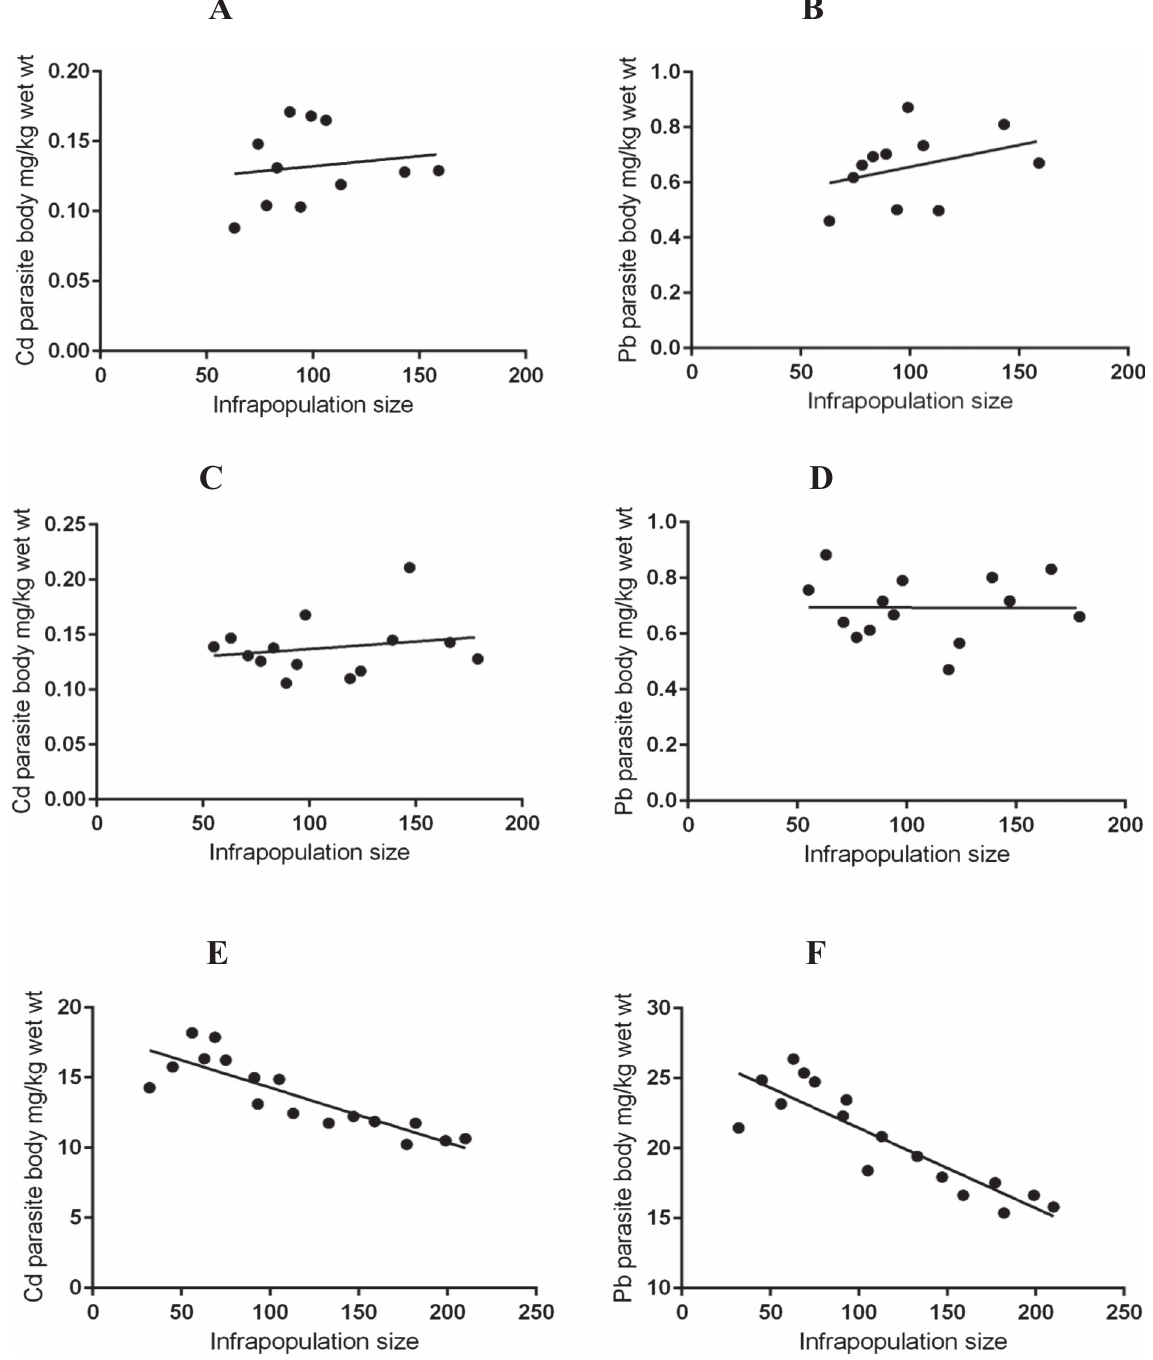
Figure 3. The relationships between metal concentrations in parasites and infrapopulation size in fi sh intestines: (A) Cd concentrations in G. volubilis vs. infrapopulation size; and (B) Pb concentrations in G. volubilis vs. infrapopulation size; (C) Cd concentrations in P. elatensis vs. infrapopulation size; (D) Pb concentrations in P. elatensis vs. infrapopulation size; (E) Cd concentrations in S. rubrimaris vs. infrapopulation size; and (F) Pb concentrations in S. rubrimaris vs. infrapopulation